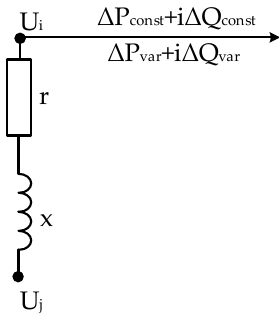
Figure 2. Equivalent circuit of the ETC element.